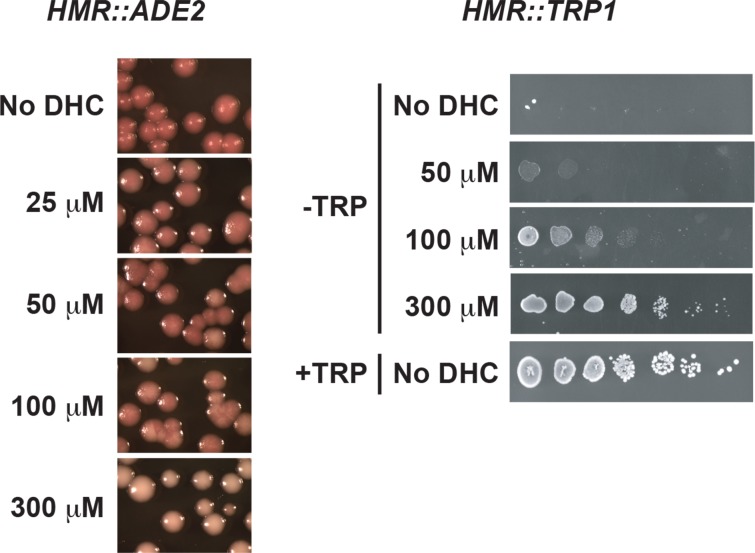
DHC inhibits silencing of reporter genes at HMR.In reporter strains, a1 and a2 at HMR were replaced by genes encoding A. ADE2 or B. TRP1. Logarithmically growing yeast were plated on rich (YPD) media (a) or minimal (YM) media (b) containing or lacking tryptophan plus the indicated amount of DHC and analyzed as outlined in Materials and methods.